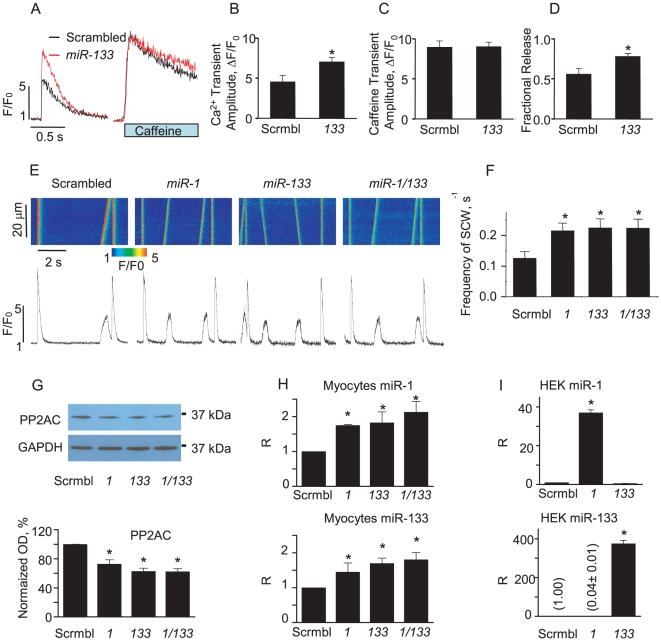
Overexpression of miR-1 and miR-133 increases the frequency of pro-arrhythmic spontaneous Ca2+ waves (SCW) in rat myocytes.A, Time dependent profiles of electrically- (field stimulation at 0.5 Hz) and 10 mM caffeine-evoked Ca2+ transients in myocytes infected with scrambled and miR-133 carrying Advs (MOI 100) after 48 hrs in primary culture. B,C,D. Pooled data for electrically and caffeine evoked Ca2+ transient amplitude and fractional release in miR-133 overexpressing myocytes vs. controls. E. Representative confocal Ca2+ images with corresponding time dependent profiles recorded in field-stimulated (0.2 Hz) myocytes in the presence of 100 nM isoproterenol infected with miR-1 and/or miR-133 Adv. F. Pooled data for the number of SCWs per second. *Statistically significant at p<0.05 vs. scrambled, n = 15–25. G. Representative Western Blots (upper panel) and pooled data (lower panel) of PP2AC in myocytes infected with control Adv (scrambled) or miR-1, or miR-133 or both miR-1 and miR-133; *<0.05 vs control, n = 6. H. Levels of miR-1 and miR-133 in myocytes assessed by qRT-PCR. *<0.05 vs control, n = 3. I. Infection of non-muscle cells (HEK) with miR-1 does not result in increase in expression levels of miR-133 and vise versa, *p<0.05 vs control, n = 3.